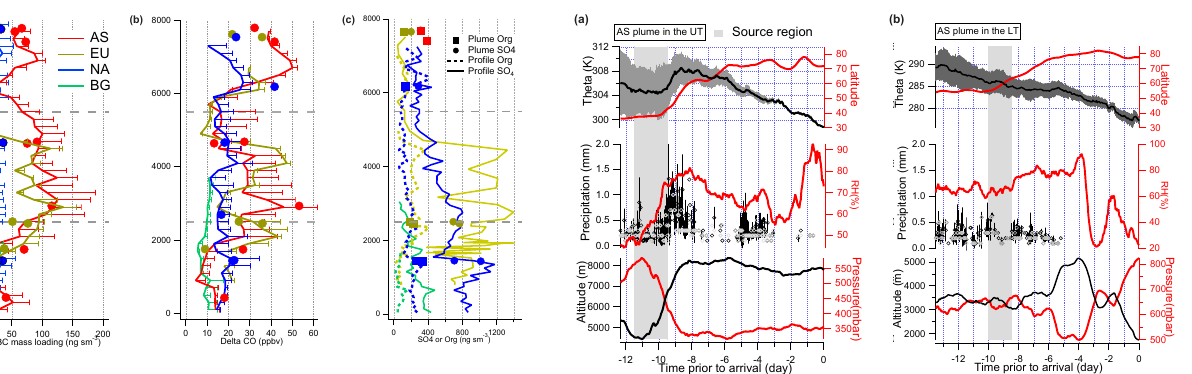
Figure 9. Average characteristics of sampled air parcel plumes ar- riving at receptor locations along 12-day backward trajectory path- ways. Panels (a) and (b) show the cases for AS plume in the UT (corresponding to B759 i plume in Table 2) and LT (B760 ii in Ta- ble 2) respectively. All parameters shown are mean values averaged over all back trajectories sampled throughout the specified plume. The bars on the precipitation and potential temperature ( θ ) data de- note the stand deviation ± σ of the ensemble of all back trajectories, and the grey markers on precipitation show the median value. The grey bars mark the time when the air masses passed over the source regions according to FPES. The identical plots for the other air mass regions are shown in Fig.